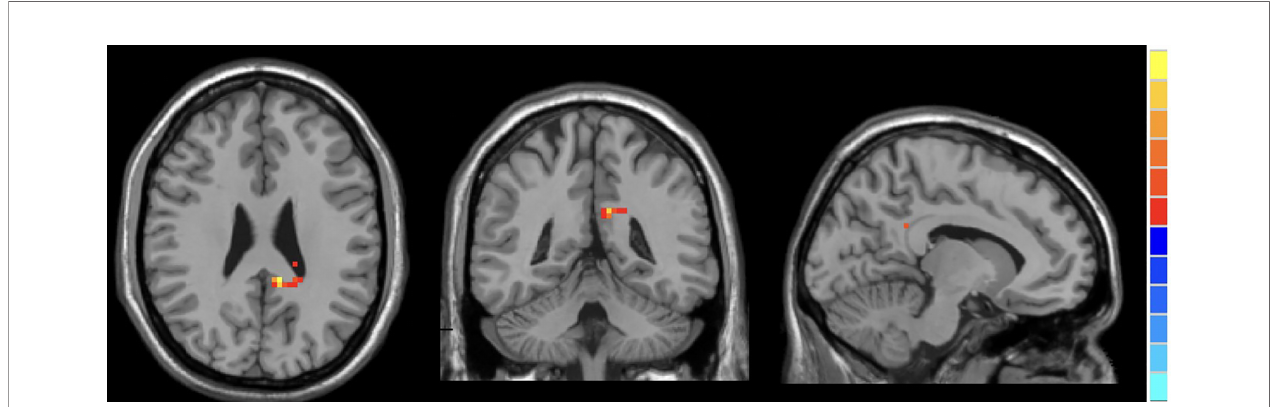
FIGURE 4 | In comparison with HCs, active TAO patients showed increased fALFF in the left posterior cingulate gyrus.